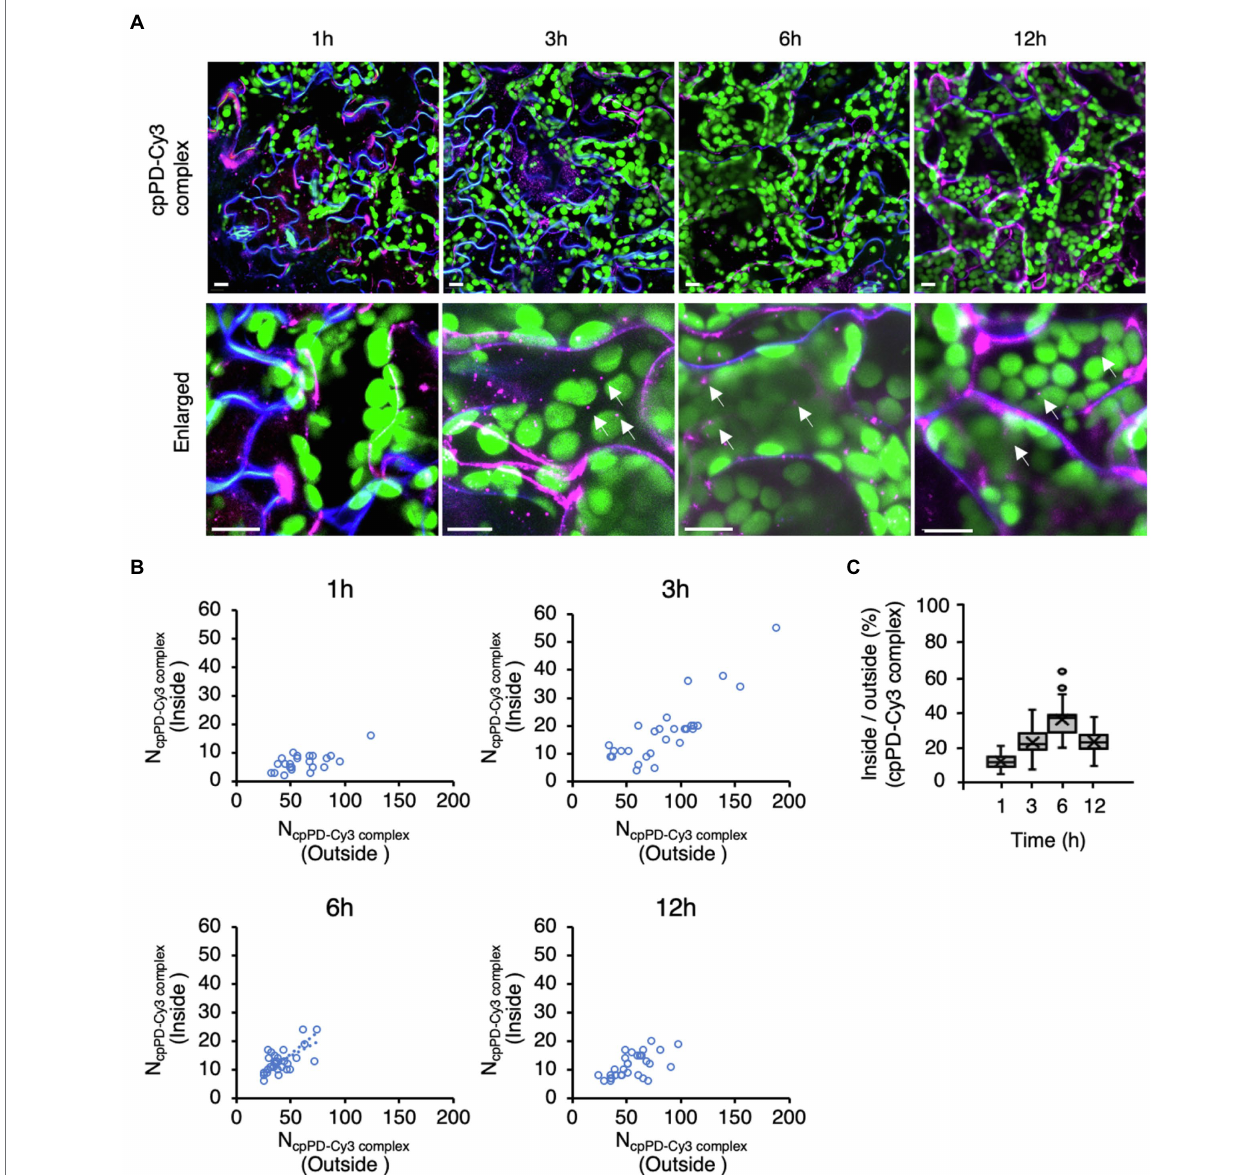
FIGURE 3 | Time-dependent penetration of KH-AtOEP34–pDNA complexes into leaf mesophyll cells. (A) Subcellular localization of KH-AtOEP34–pDNA complexes labeled with Cy3 (cpPD-Cy3; magenta) in Arabidopsis leaf mesophyll cells at 1, 3, 6, and 12 h after infiltration. Enlarged images are shown in the lower panels. The plasma membrane (blue) is stained with FM4-64. Chloroplasts (green) are visualized as chlorophyll autofluorescence. Scale bars denote 10 μ m. (B) Scatterplots showing the relative spatial distribution of cpPD-Cy3 complexes at the different time points shown in (A) . Each circle represents a cell with the number of cpPD-Cy3 complexes outside ( x -axis), N cpPD-Cy3 complex (Outside), and inside ( y -axis), N cpPD-Cy3 complex (Inside), the cell ( n > 24). (C) Ratio of the number of cpPD-Cy3 complexes inside and outside cells shown in (B) , as box plots. The horizontal lines represent the mean and the cross represents the median. Circles represent